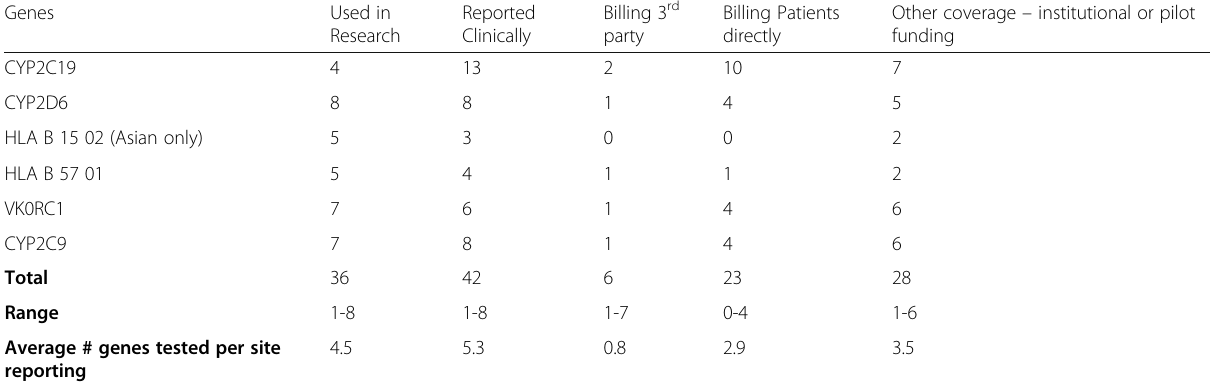
Table 3 Number of respondents reporting use, billing and funding for the 6 genes reimbursed by Medicare and Medicaid Genes